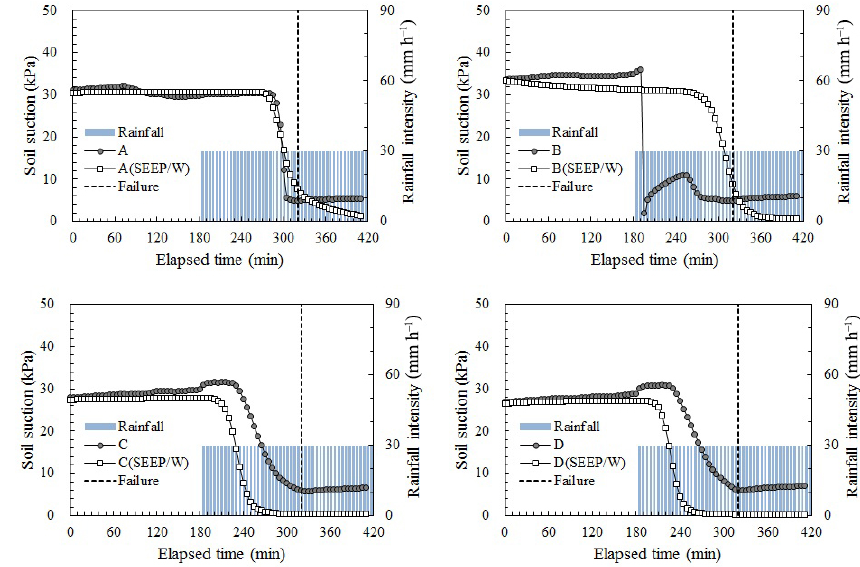
Figure 10. Comparison of soil suction of experimental data and results of numerical analysis in the model slope of 70 ◦